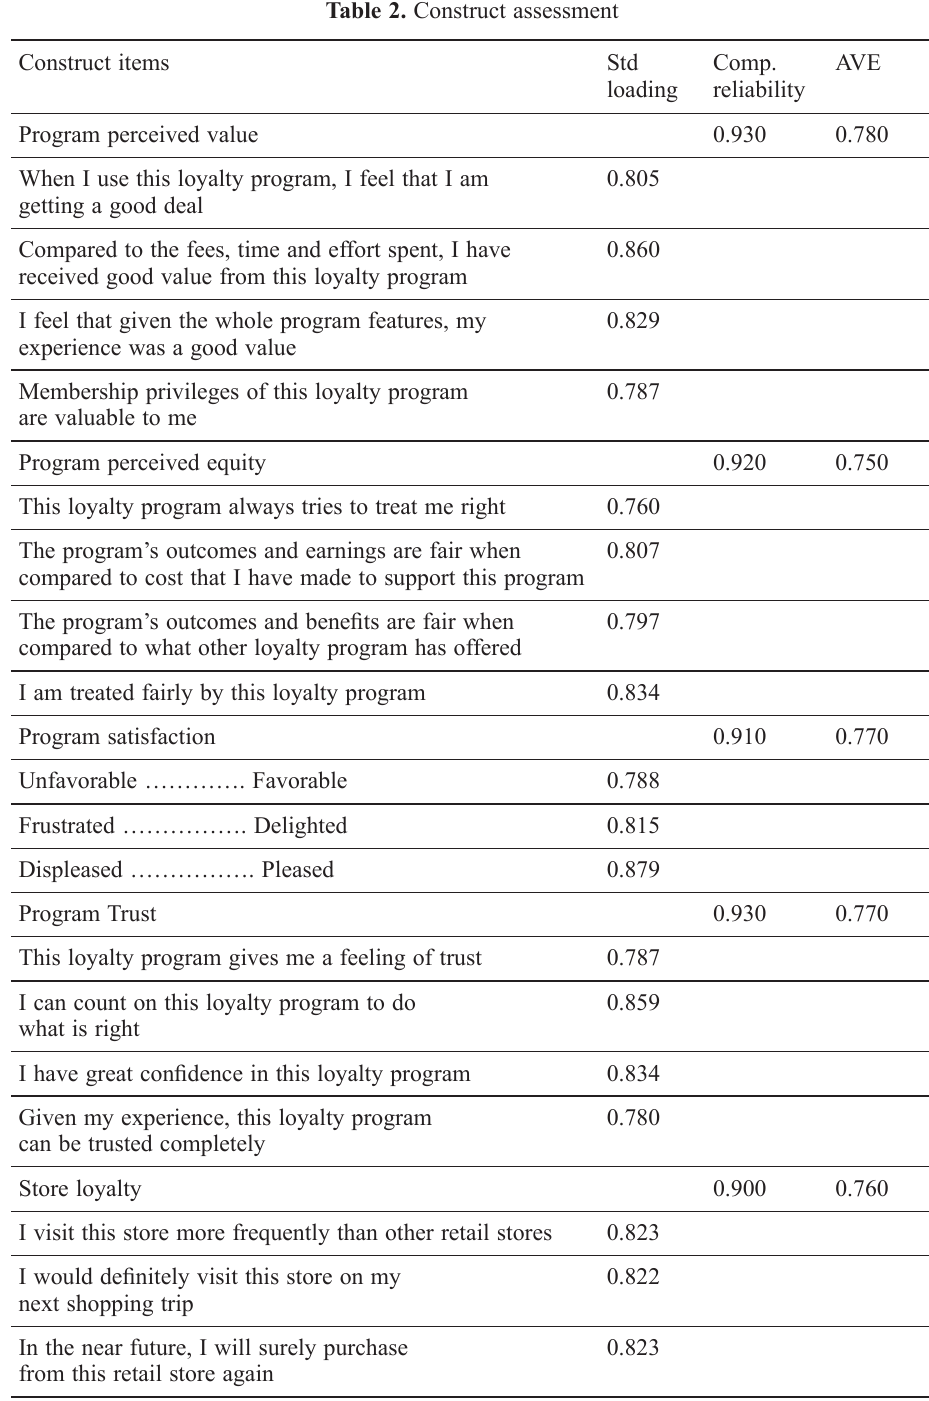
Table 2. Construct